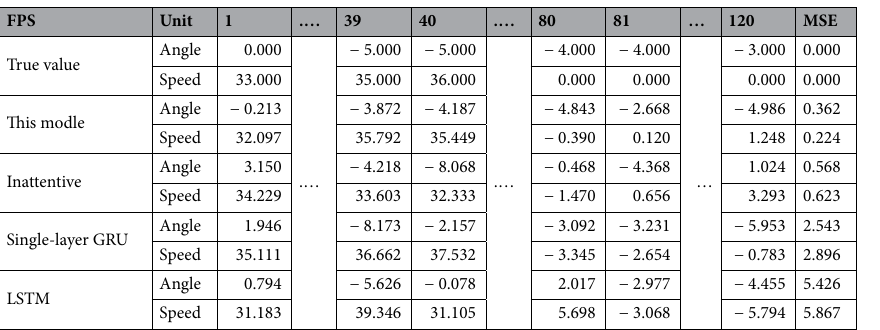
Table 2. Comparison of prediction results of different prediction models.